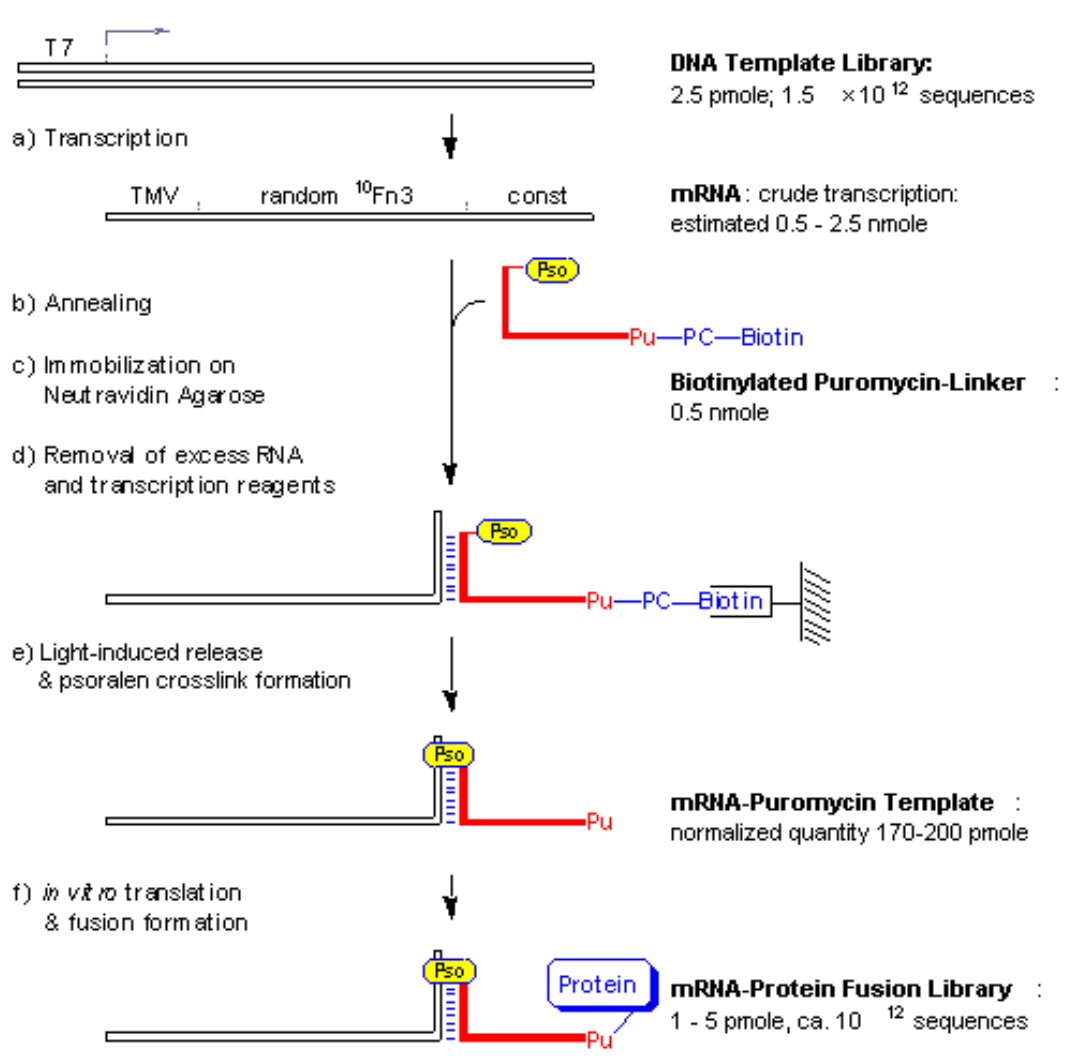
Figure 1 : Schematic outline of mRNA-protein fusion synthesis. A double stranded DNA template library was in vitro transcribed to produce the mRNA template (a) which was annealed with a limiting amount of biotinylated puromycin-linker (b) and subsequently captured on neutravidin beads (c) After a washing step to remove unbound mRNA (d) the beads were irradiated with UV light (e) Elution yielded the photo-ligated mRNA-puromycin template which was directly subjected to in vitro translation to form the mRNA-protein fusions library (f) T7, transcription promoter sequence; TMV, a portion of the tobacco mosaic virus 5’-UTR with good initiation codon context; random 10 Fn3, a sequence coding for a randomized 10th fibronection type III domain; const, a constant sequence which codes for the linker hybridization and crosslinking sites as detailed in Fig. 2; Pu, puromycin; Pso, psoralen; PC- biotin, a photo-cleavable biotin-tag described in Fig.